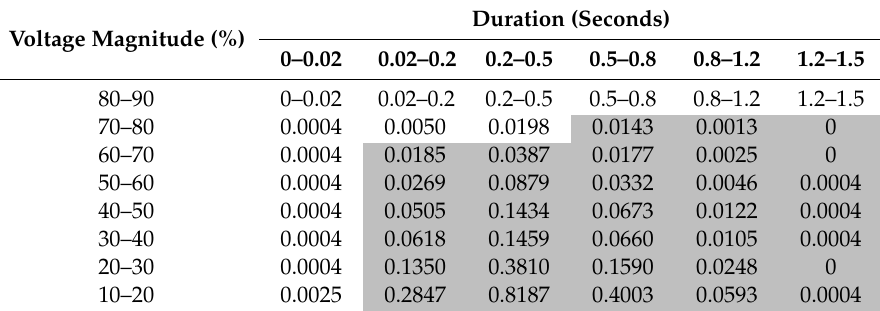
Table 6. SSD for the network under study.